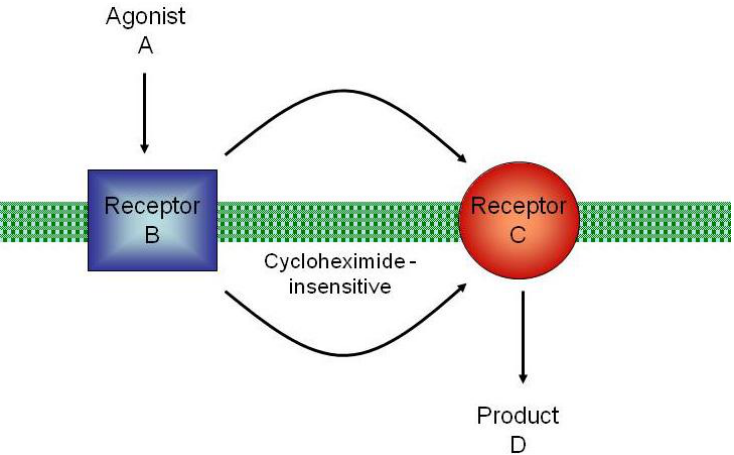
FIGURE 1. Model of GPCR receptor to protein kinase receptor transactivation. An agonist A of a receptor B, in this case a GPCR, leads via a mechanism, which is insensitive to the protein synthesis inhibitor cycloheximide, to the activation of a second receptor C, in this case a protein kinase receptor, and the formation of the product D, a phosphorylated signaling intermediate often being a transcription factor. The process is required to occur in a relatively short time frame to constitute “transactivation”. A specific new example is given in Fig.